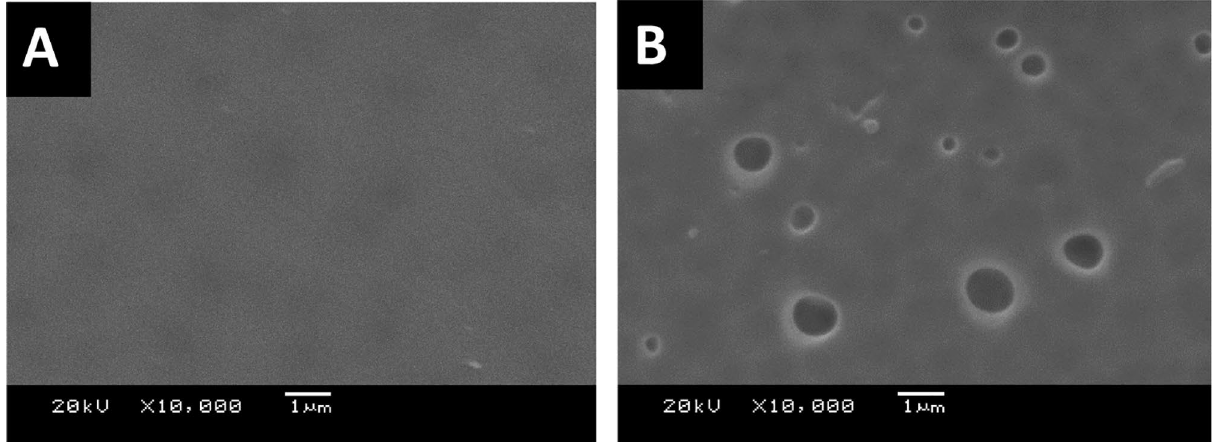
Figure 6. SEM images of the front ( A ) and the back ( B ) of the blank PES membranes that were prepared using 1 NMP: 9 DMF solvents mix with Lithium chloride.